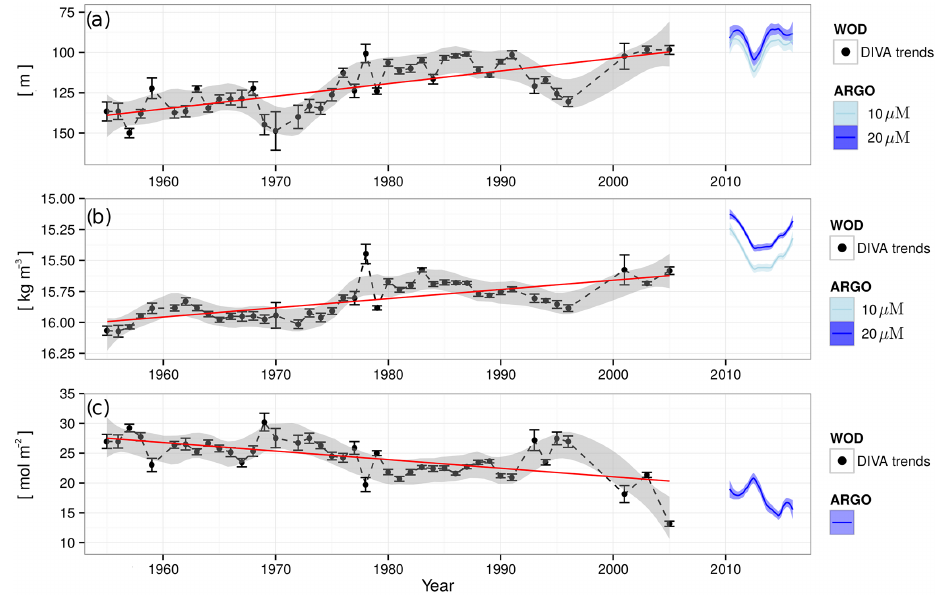
Figure 6. Trends of (a) oxygen penetration depth, (b) oxygen penetration density level ( σ θ ) and (c) oxygen inventory deduced from (dots) DIVA analysis of ship-based casts and (blue) ARGO floats. In (a) and (b) , the diagnostics from ARGO are also shown for the lower threshold of 10µM to acknowledge a potential bias between Winkler and Argo data. Red lines: the linear trends assessed from the ship-based data set are − 7.9mdecades − 1 , − 0.074kgm − 3 decades − 1 and − 1.44molOm − 2 decades − 1 for (a) , (b) and (c) , respectively. Error bars on DIVA estimated trends indicate the standard error associated with the estimation of the mean misfit for each year (see Appendix